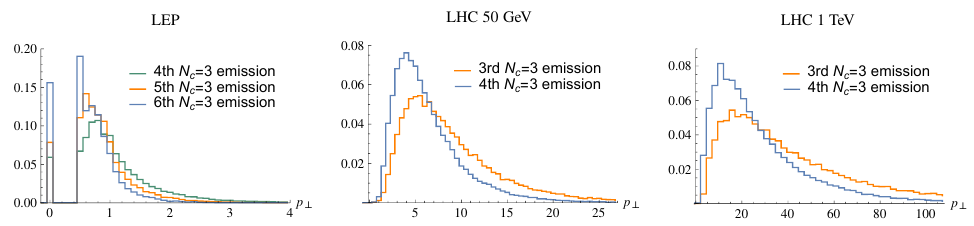
Figure 3 . Transverse momentum distribution in the dipole frame of the last N c = 3 emission (orange) and the (cid:12)rst non-corrected emission (blue). For LEP the second-to-last N c = 3 emission is also shown (green). For LHC we use a 50 GeV (middle) and a 1 TeV (right) cut on the hardest parton. The shower cut-o(cid:11) at LEP is 0.45 GeV, and events which reach this scale are shown in the 0-bin